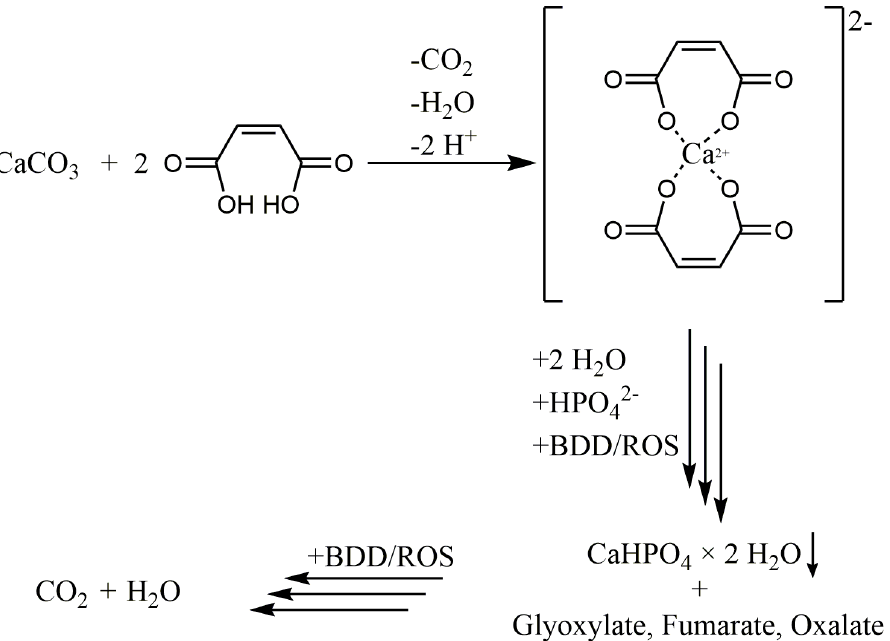
Figure 16. Proposed reaction pathway of complex building and BDD mediated decomposition. The formation of a calcium maleate complex prevents the precipitation in the highly supersaturated solution (referred to as brushite and other calcium phosphates).